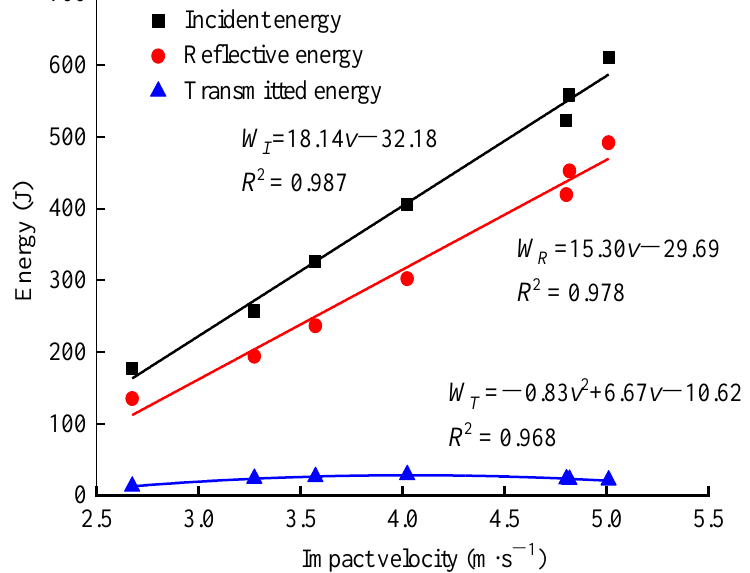
Figure 10. The relationship of incident, reflective, and transmitted energy with impact velocity.